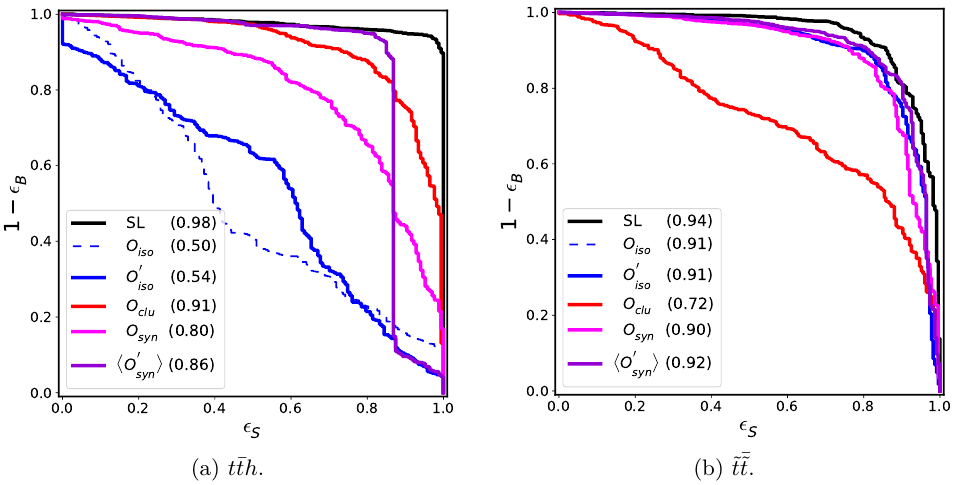
Figure 17 . ROC curves and their AUC values (given in brackets) for the set of novelty evaluators considered, applied for the signal and background events in the t ¯ tγγ analysis. The signal events considered correspond to (a) t ¯ th and (b) ˜ t ¯˜ t . Here r = 0 . 6 is taken to define the signal-like sample 0 . As a reference, the SL performance has also been reported. S 0 for training O 0 syn